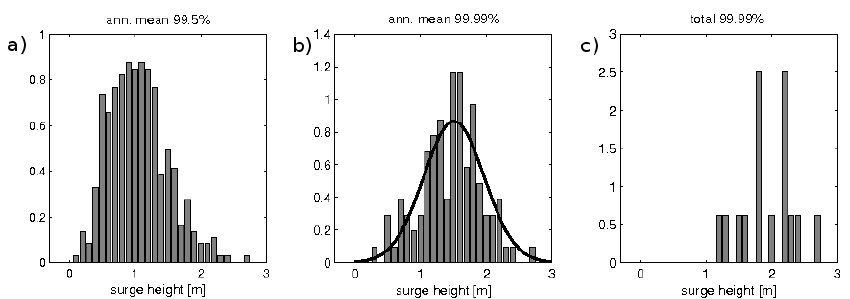
Fig. 4. Histograms for hindcast storm surge events at point 156 (location see Fig. 1) obtained with thresholds (a) annual mean 99.5%,